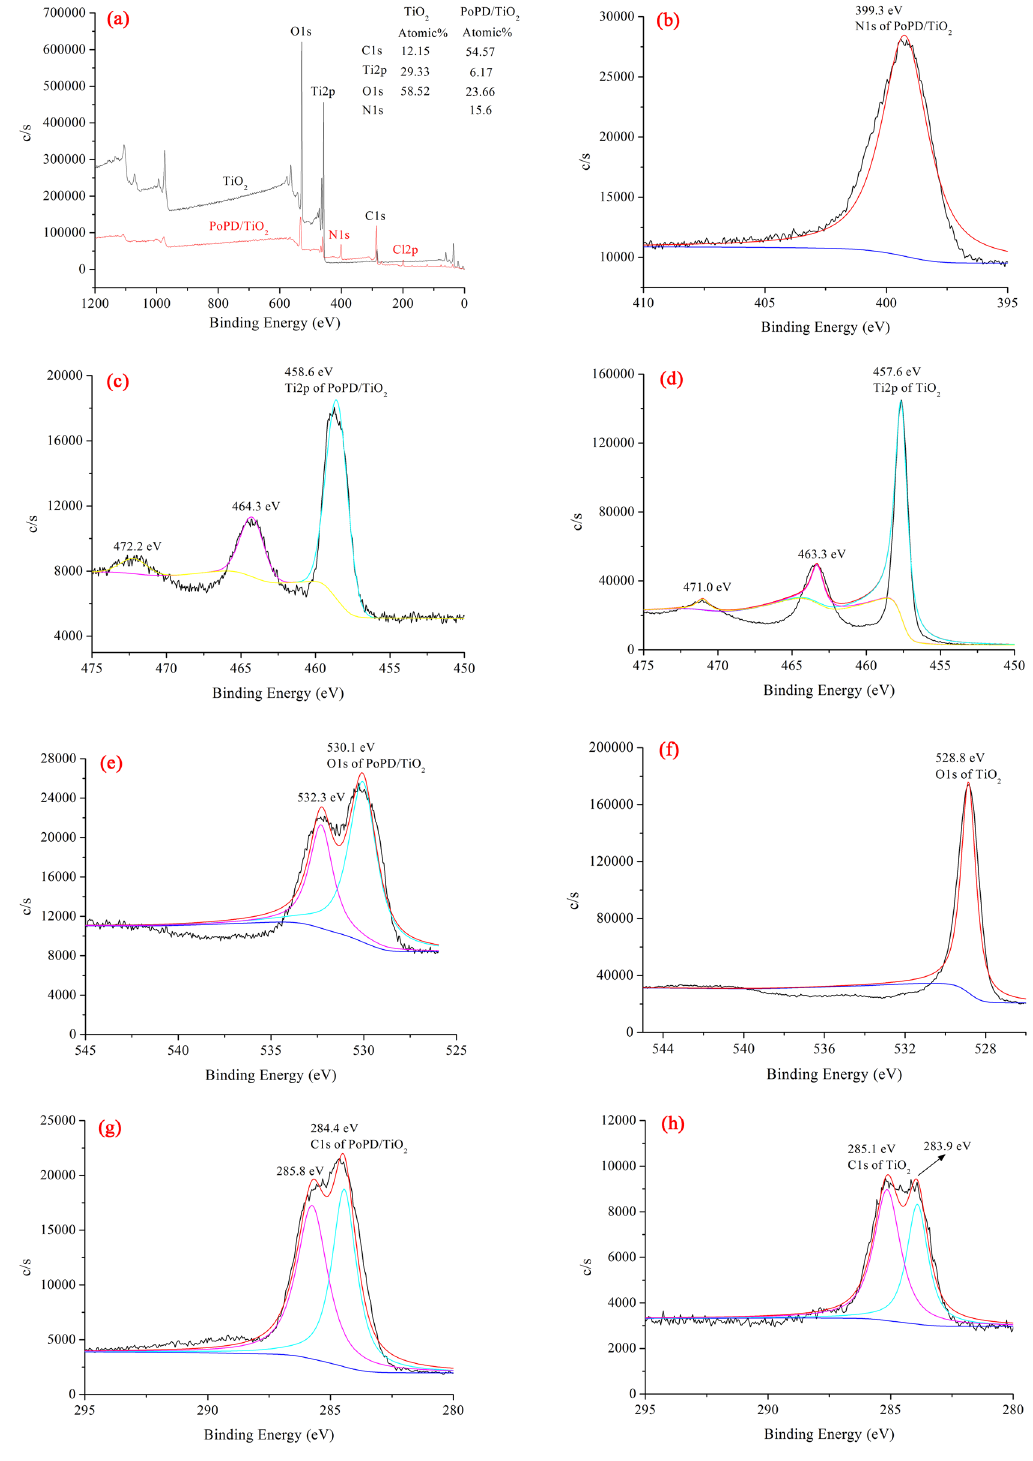
Figure 6. XPS spectra of TiO 2 and